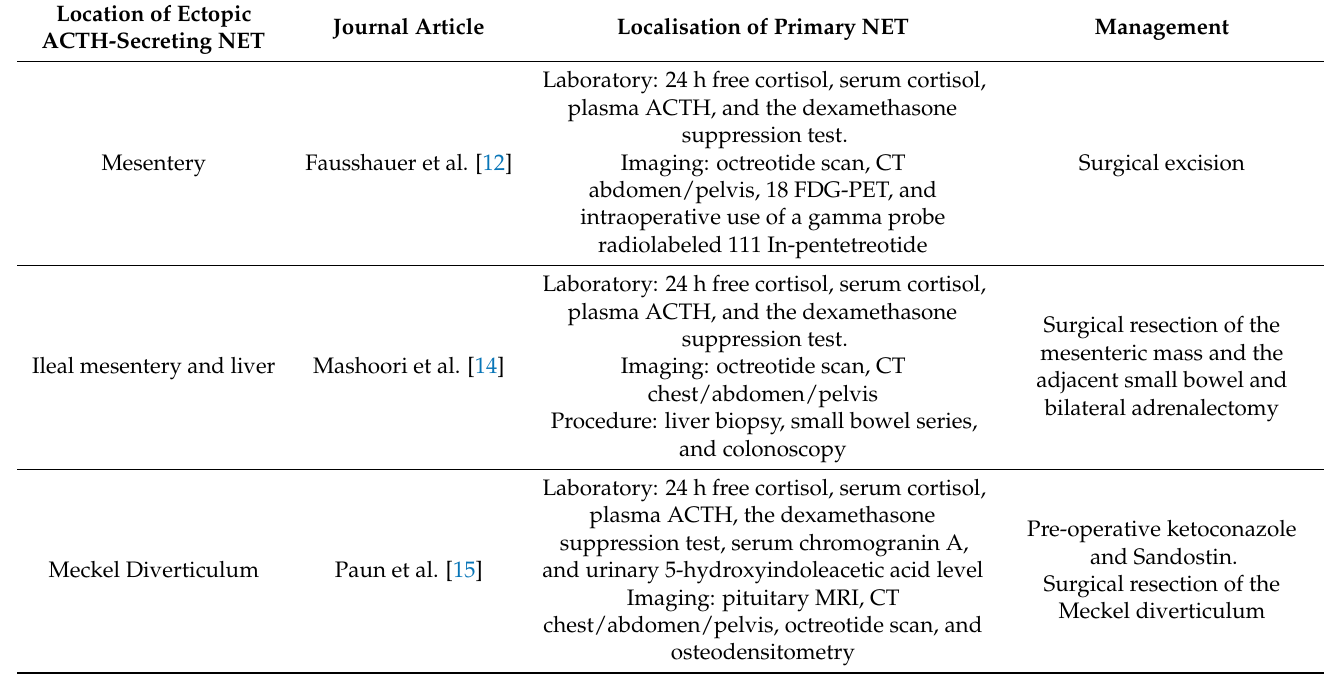
Table 1. Table comparing the localisation techniques and management from case reports of ectopic ACTH-secreting NETs of the small bowel and/or